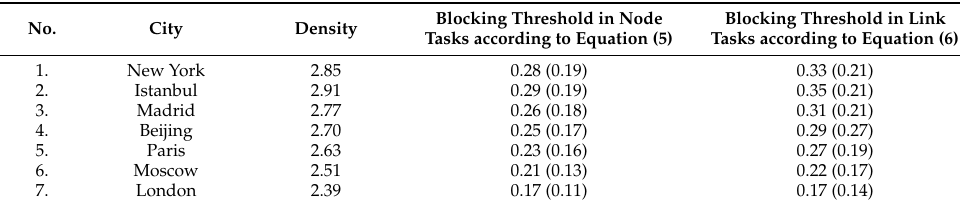
Table 4. Densities of transport bonds in any world cities and the values of their blocking thresholds calculated using models of regular